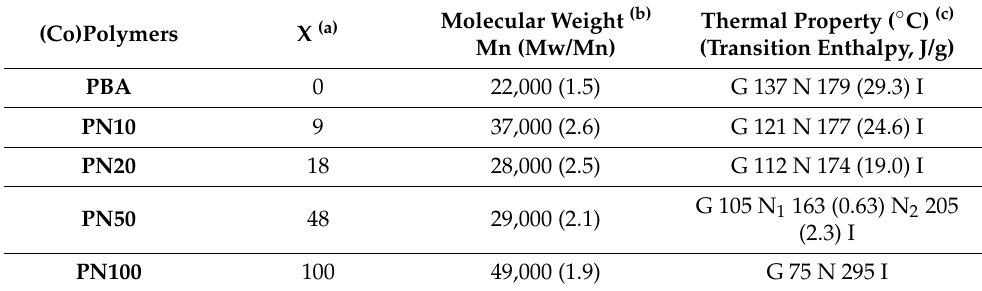
Table 1. Composition, molecular weight, and thermal property of (co)polymers.